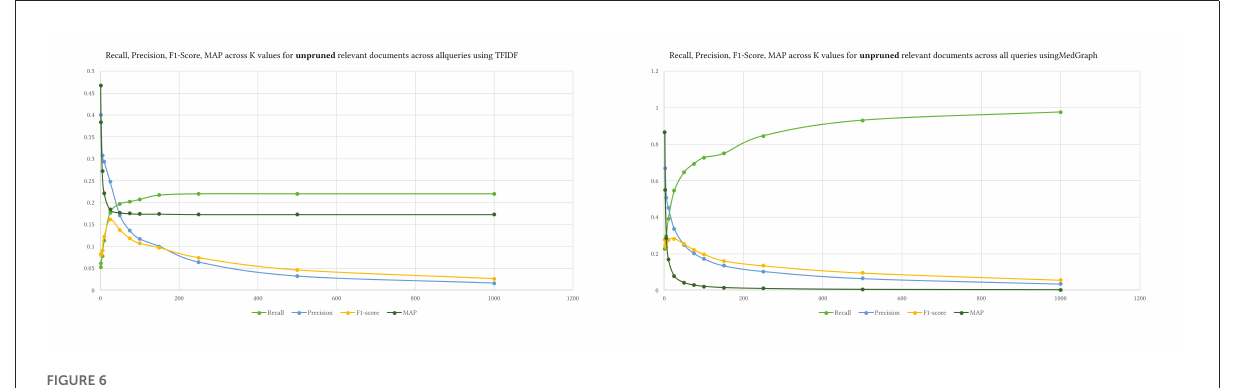
FIGURE6 MedGraph vs. TFIDF on all four